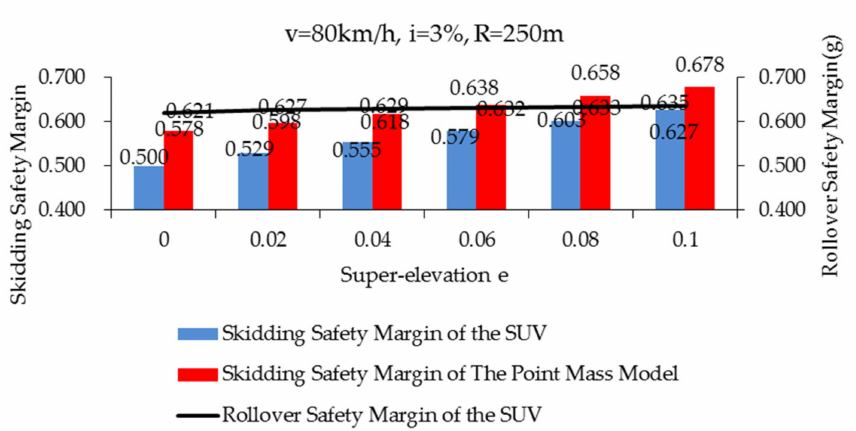
Figure 8. Skidding and safety rollover margin of vehicles on good friction pavement ( f Tmax = 0.85) (Case 1–6, in Table